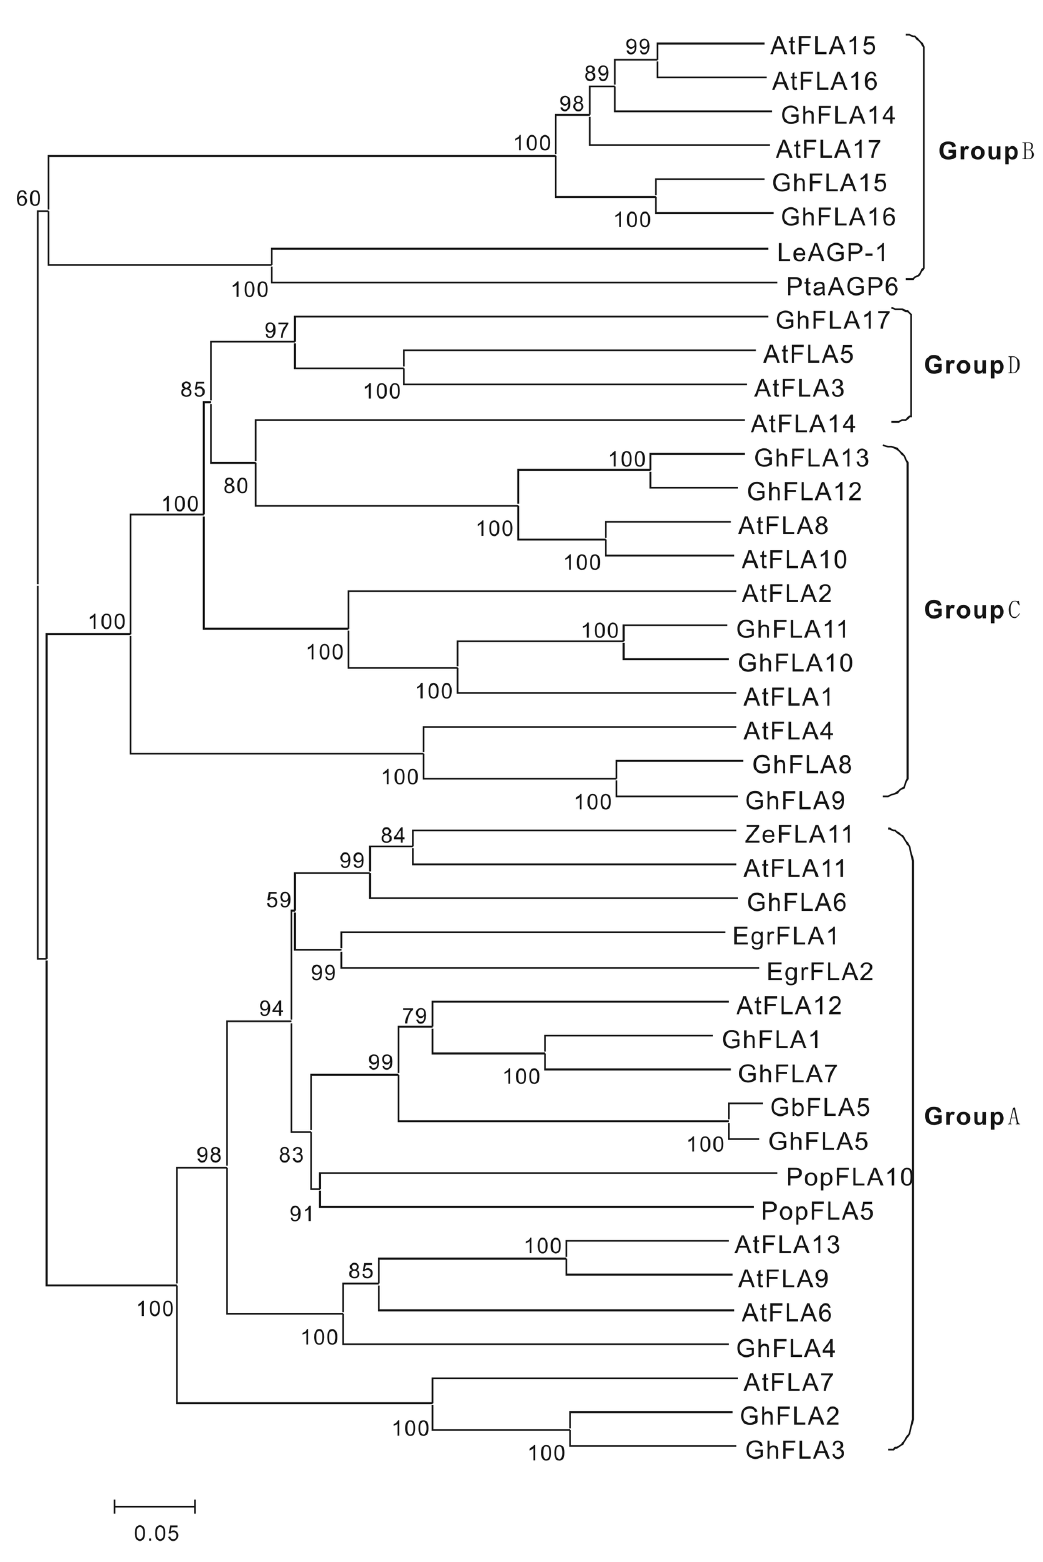
Figure 4. Phylogenetic relationships of GbFLA5 with homologous FLAs in Upland cotton and Arabidopsis . The neighbor- jointing tree was constructed with MEGA 4.0. Subgroup of A to D reference to Huang et al. (2008). doi: 10.1371/journal.pone.0070185.g004 PLOS ONE |